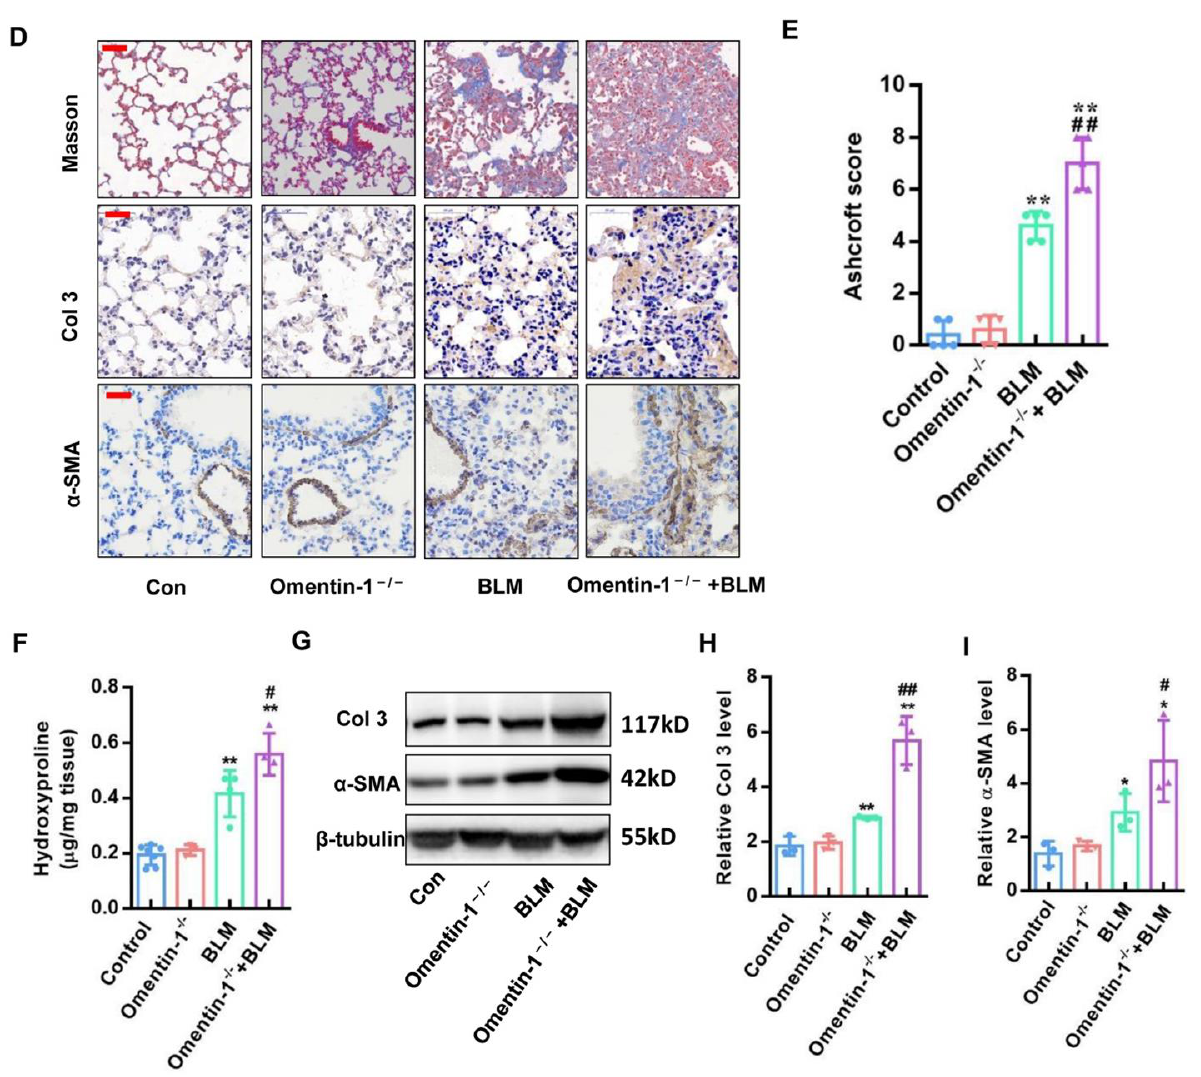
Figure 2. The effect of omentin-1 deficiency on BLM-induced lung fibrosis at 21 d. ( A ) Experimental design: BLM (1.0 mg/kg) was injected to induce fibrosis (21 days) in wild-type and Omentin-1 − / − mice. ( B ) Weight change of mice 21 days after BLM challenge ( n = 10). ( C ) Representative micrographs of H&E staining of lung tissue (Bar = 50 µ m, n = 5). ( D ) Representative micrographs of Masson trichrome staining, immunohistochemical staining of lung sections for Collagen III (Col3) and α -SMA (Bar = 50 µ m, n = 5). (E) Ashcroft score to grade fibrosis scale ( n = 5). ( F ) Collagen content was measured by hydroxyproline (HYP) assay ( n = 5). ( G ) The content of collagen III (Col3) and α -SMA in lung tissue detected by Western blotting with cropping gel at the relative molecular size. ( n = 3). ( H ) Semi-quantitative analysis of Col3 level evaluated by Western blotting. ( I ) Semi-quantitative analysis of α -SMA level evaluated by Western blotting. The data are presented as the mean ± SD. * p < 0.05, ** p < 0.01 vs. control group. # p < 0.05, ## p < 0.01 vs. BLM